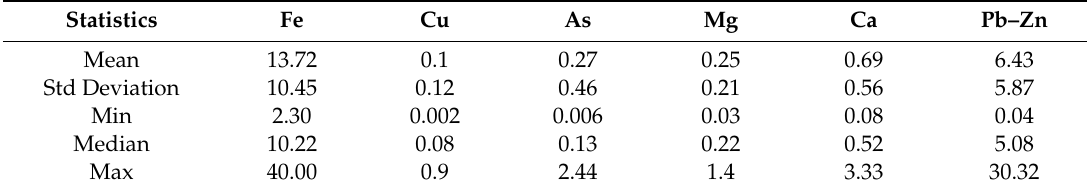
Table 1. Summary statistics of elemental concentrations (in wt.%) in the analyzed samples.